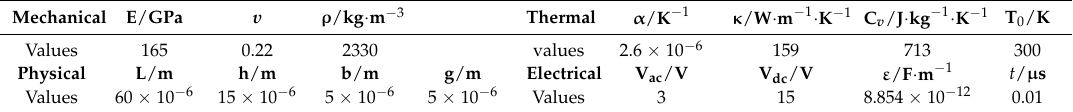
( b ) Figure 4. Influence of electrostatic parameters on the field quantities along the axial direction of movable comb finger; ( a ) u , θ versus Vac; ( b ) u , θ versus Vdc. 4.2. Thermoelastic Behaviors of Micro-Comb Finger Vibration without Electrostatic Load In order to measure the effect of electrostatic load on the thermal and vibration couple process, the vibration with electrostatic load and without load is compared. The results are graphically presented in Figure 5. Note that the longitudinal free vibration moves around the first resonance frequency. From Figure 5, there is a quite obvious difference in the displacement under two different conditions. The discrepancy is about 0.1 µm in displacement, and the temperature variation shows 1.0 K difference. From the results, the thermoelastic coupling strength of micro-comb fingers with electrostatic load is stronger than that without electrostatic load.